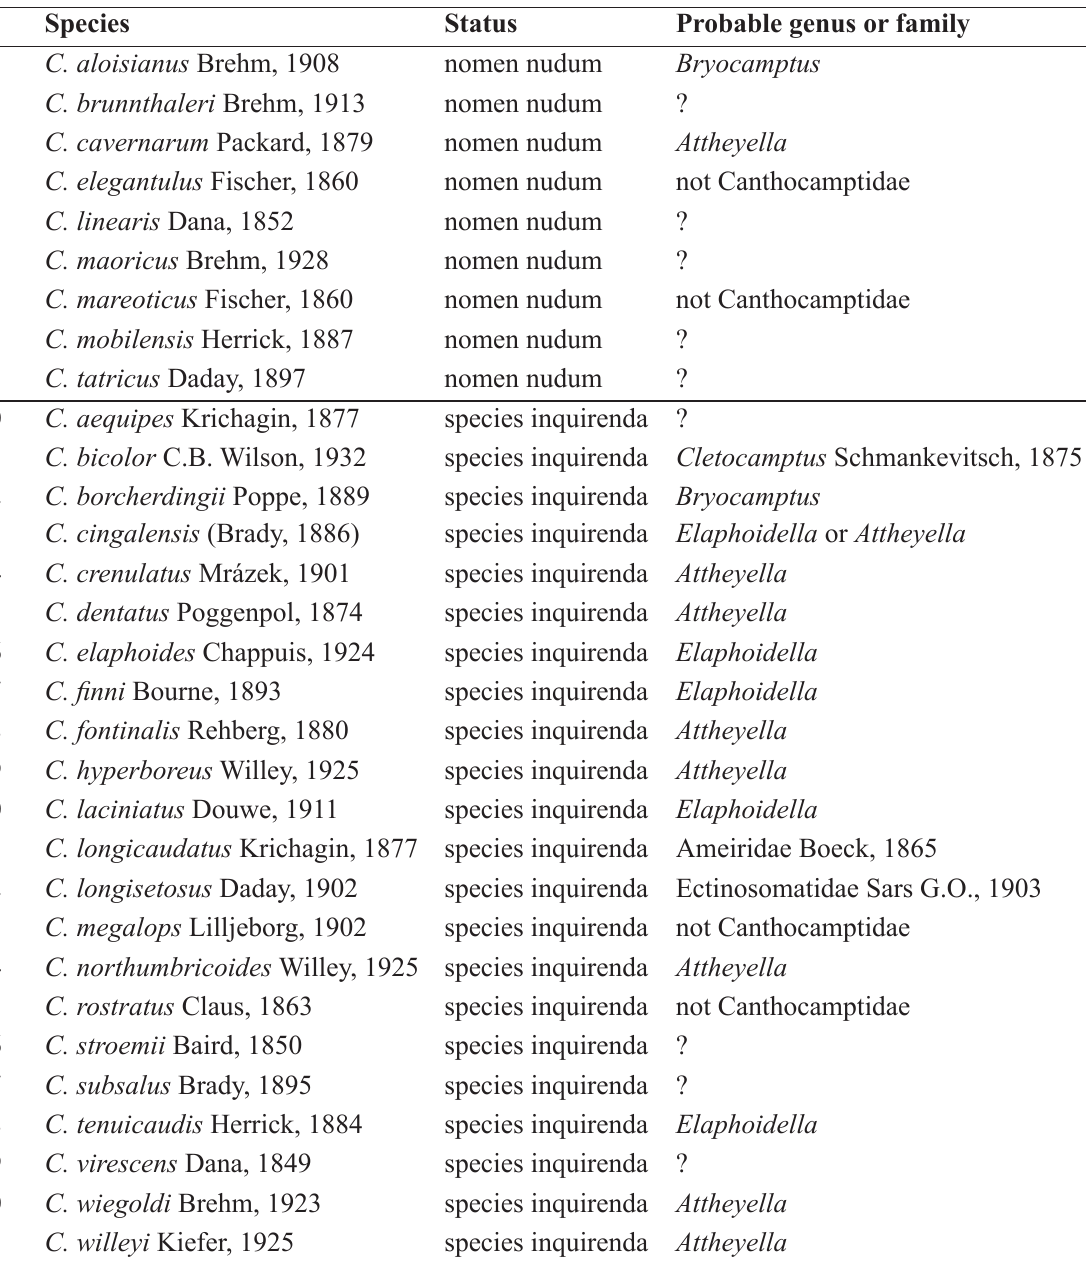
Table 5. List of species of Canthocamptus Westwood, 1836, valid according to WoRMS (Walter & Boxshall 2021), that should be treated as species nomina nuda (according to Lang, 1948) or